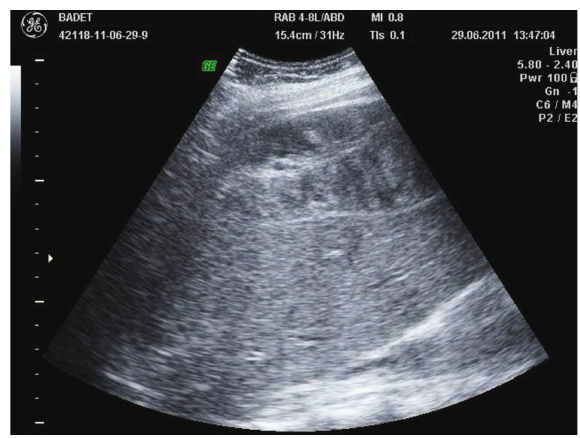
Figure 1: Liver ultrasound reveals large subcapsular hematoma.